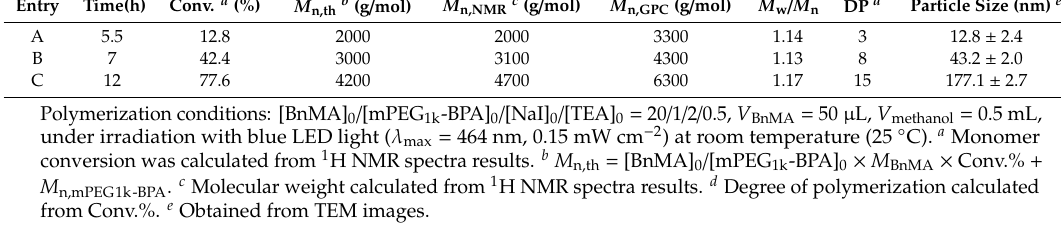
concentration at 20.0 wt %.